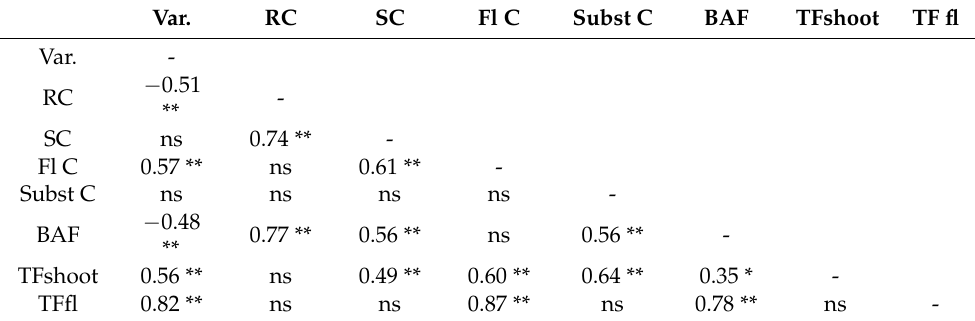
Table 10. Pearson correlation coefficients among main variables at flowering stage of Vicia faba . Var. RC SC Fl C Subst C BAF TFshoot TF fl Var.